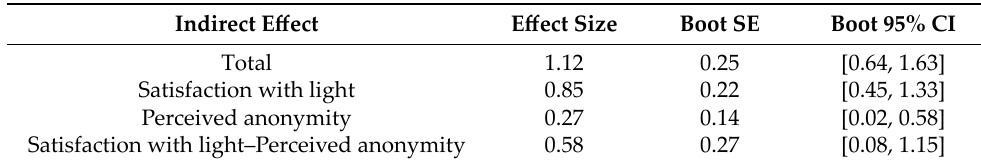
Table 6. Results of mediation